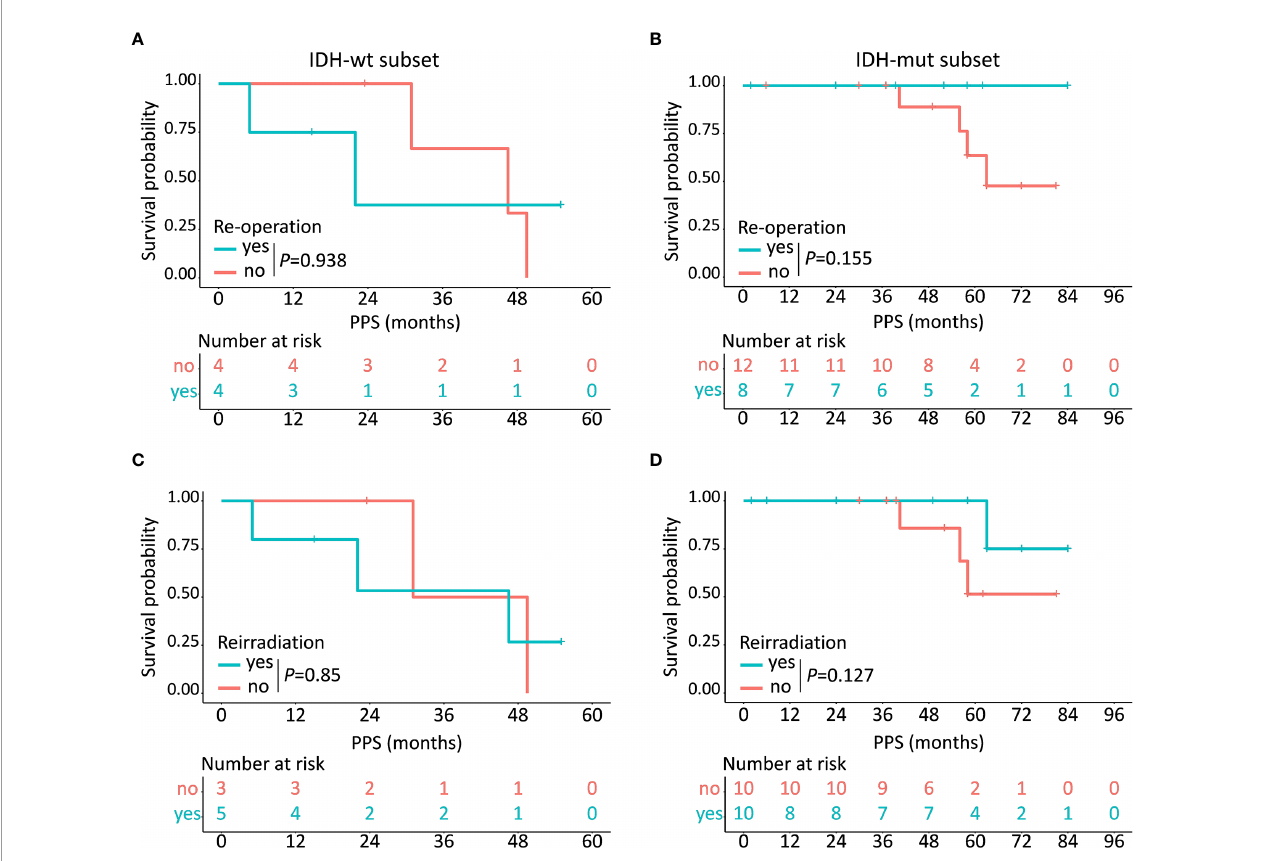
FIGURE 5 | Prognostic implications of different kinds of treatment regimens in IDH-wt and IDH-mut subtypes. In the subset of IDH-wt LTS, no obvious clinical bene fi t has been observed after receiving re-operation (A) or reirradiation (C) while IDH-mut LTS show a trend towards increased survival after receiving re-operation (B) and reirradiation (D)